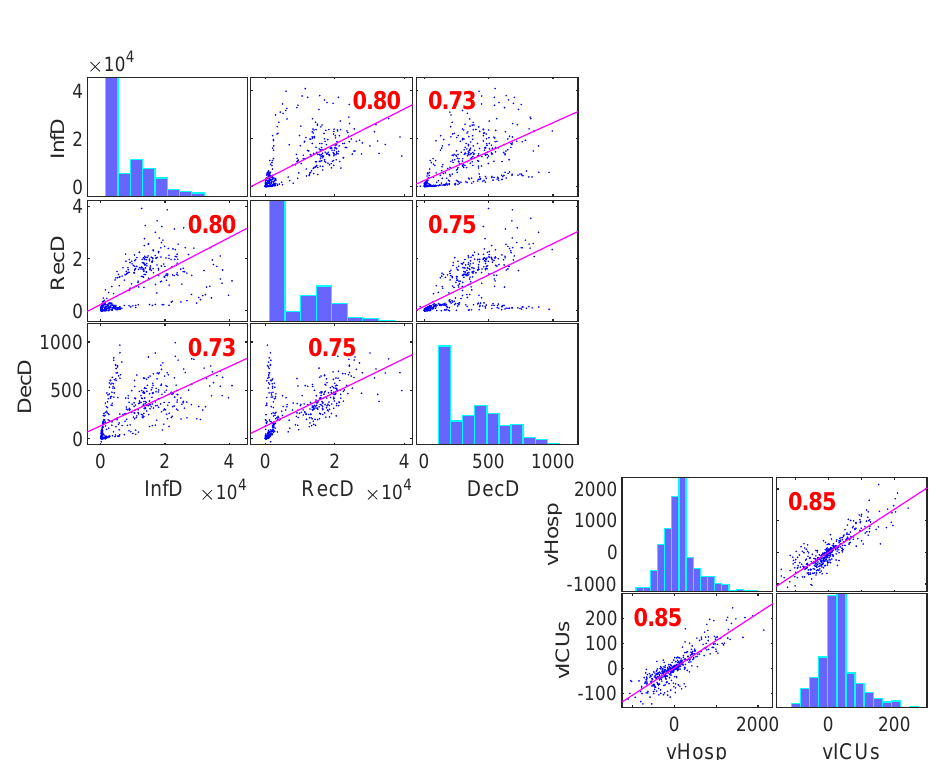
Figure 3. Scatter plot matrix between daily data for infected, deceased and recovered people ( top left ), and for daily variations of hospitalized and admitted to intensive care (ICUs) ( bottom right ). The results of Spearman test are shown in the off-diagonal plots whereas the diagonal panels report the single variables histograms.